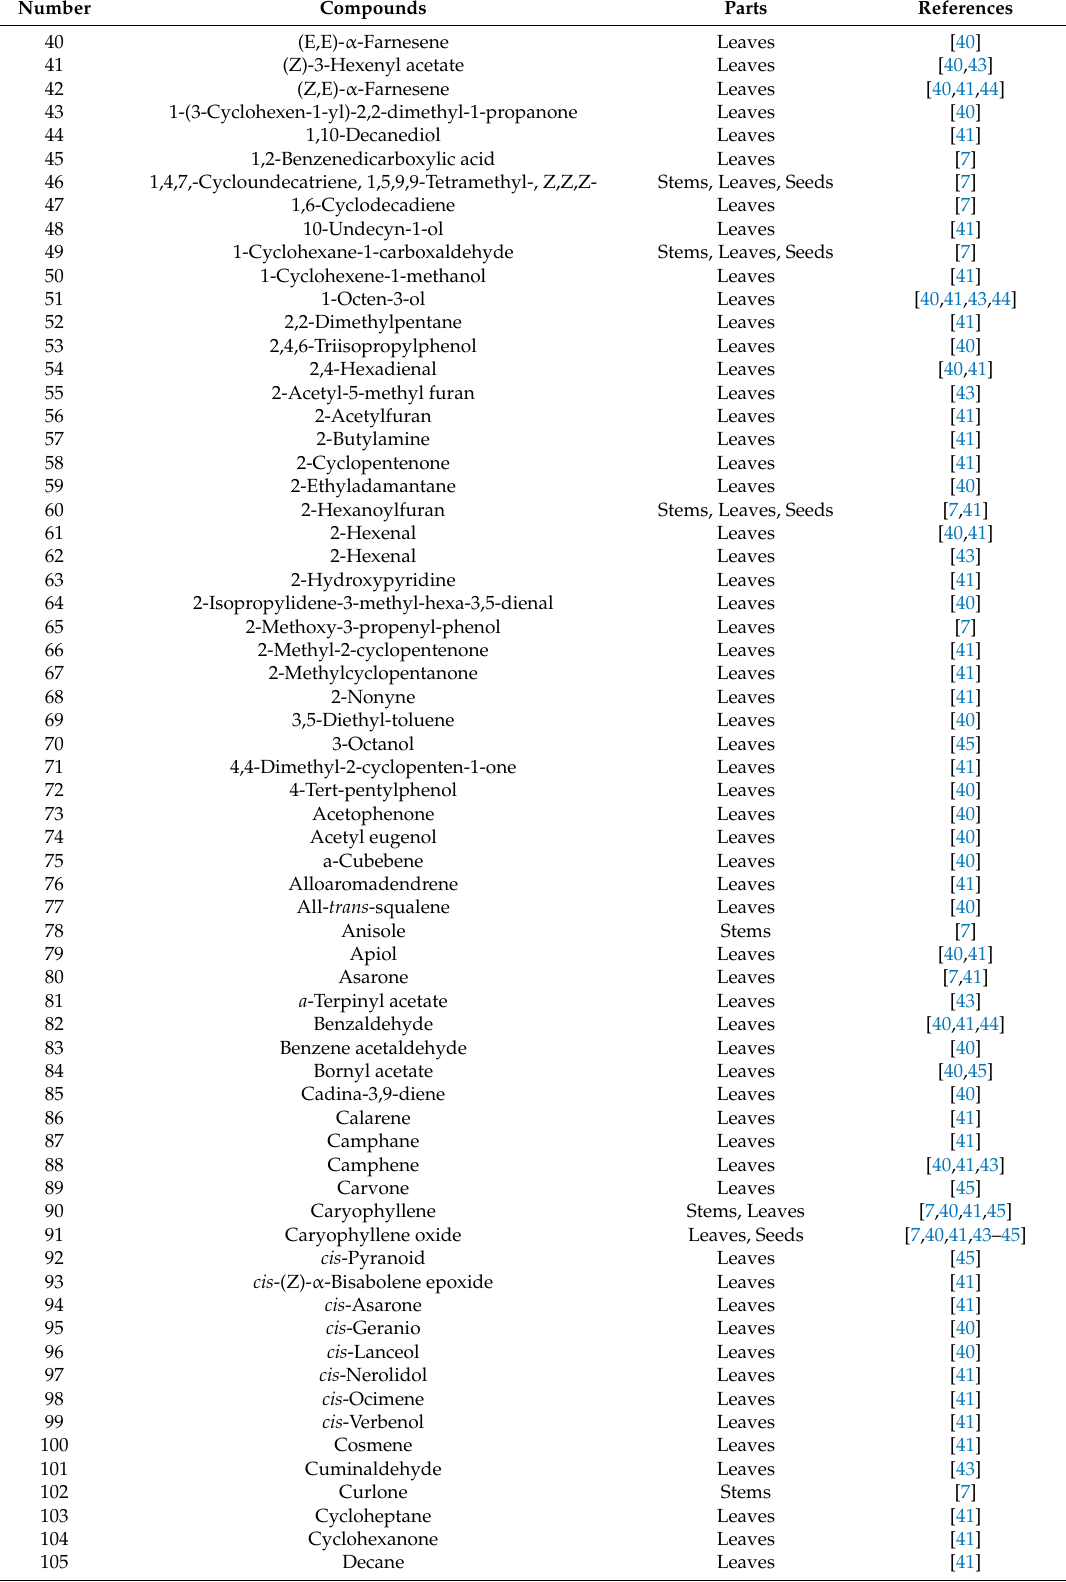
Table 2. Volatile oil compounds found in Perilla frutescens